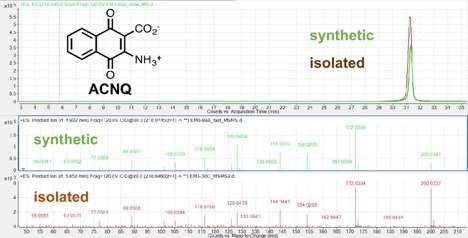
Comparison of positive mode fragmentation pattern of ACNQ isolated from MR-1 spent supernatant (bottom) and synthesized material (top).All fragmentation matched and both metabolites eluted at the same time thus confirming the structure of the natural product.